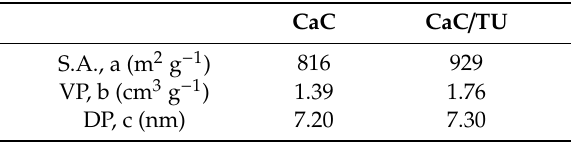
Table 1. Textural properties of the mesoporous carbon.